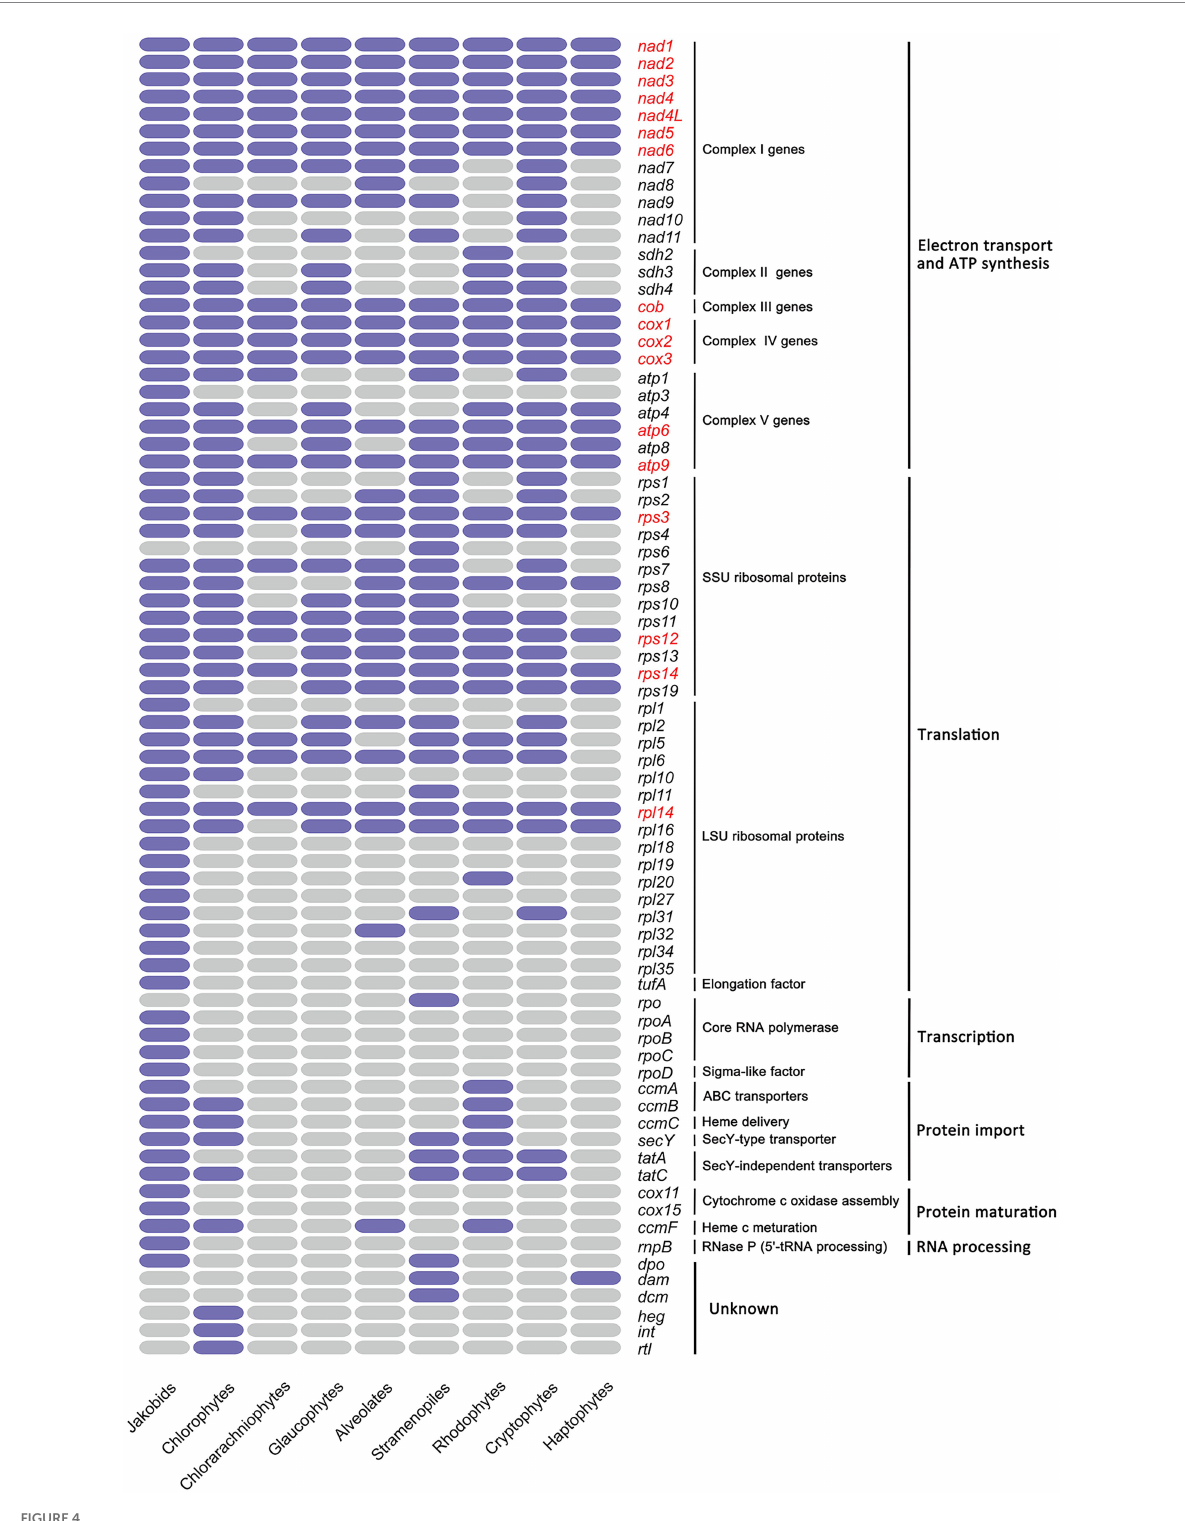
FIGURE 4 Heat map comparing gene content among the mitochondrial genomes of nine algal lineages. Only protein-coding genes with known functions are included. Purple color indicates the gene present in that group while grey color indicates absent; The 17 genes conserved among all groups are highlighted in red. Only one mitochondrial genome sequence ( Lotharella oceanica ) in Cercozoa (Chlorarachniophytes) that could be searched in GenBank. Complex I genes encode subunits of NADH dehydrogenase; Complex II genes encode subunits of succinate dehydrogenase; Complex III genes encode subunits of cytochrome bc1 complex; Complex IV genes encode subunits of cytochrome c oxidase subunits; Complex V genes encode subunits of ATP